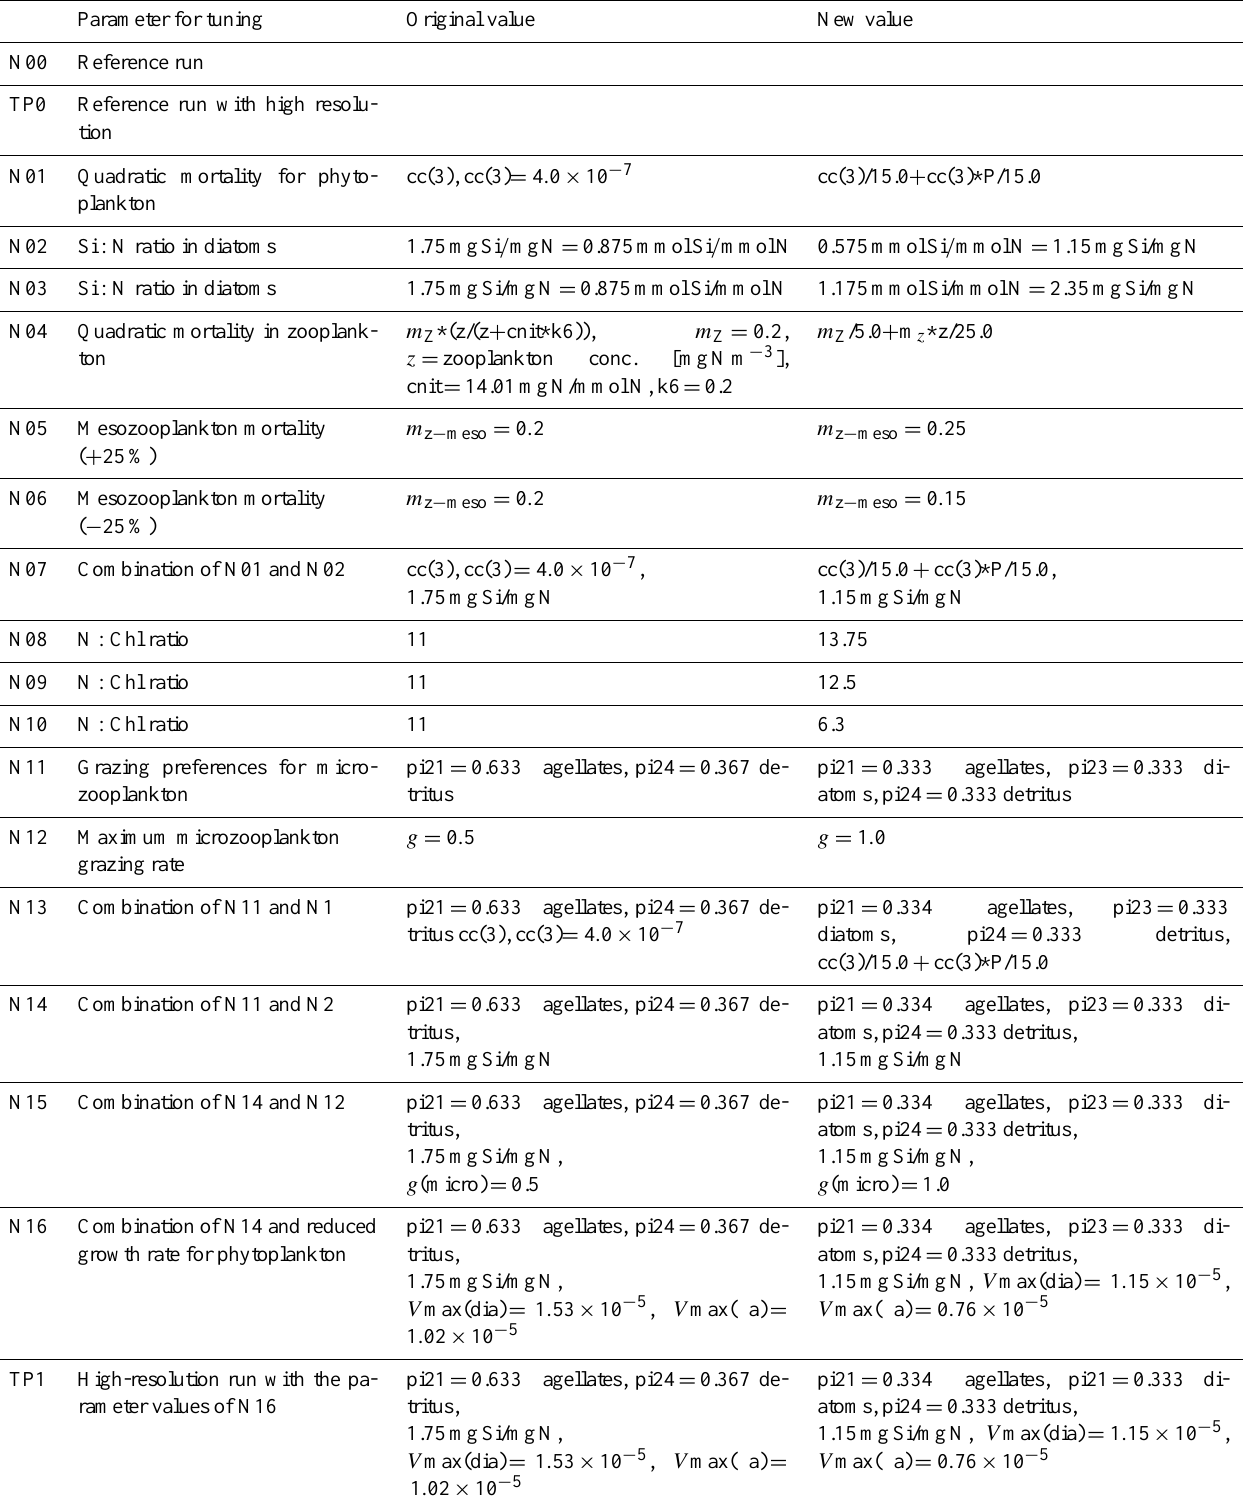
Table 2. Overview of runs performed with the associated parameter values. Parameter for